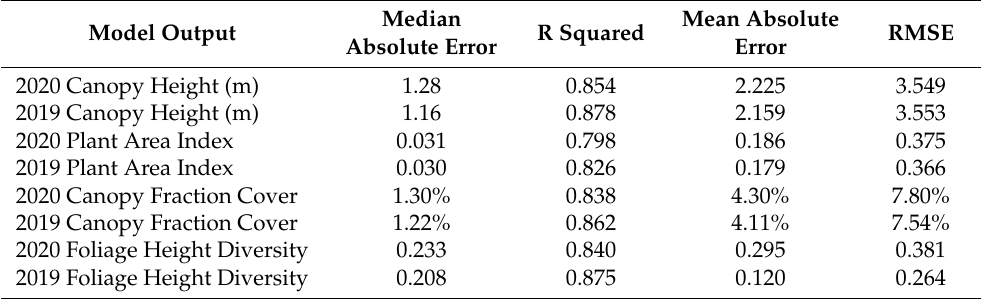
Table 10. Evaluation results of the 2020 and 2019 mapped forest structure attributes obtained by comparisons with their corresponding 2020 and 2019 GEDI-derived